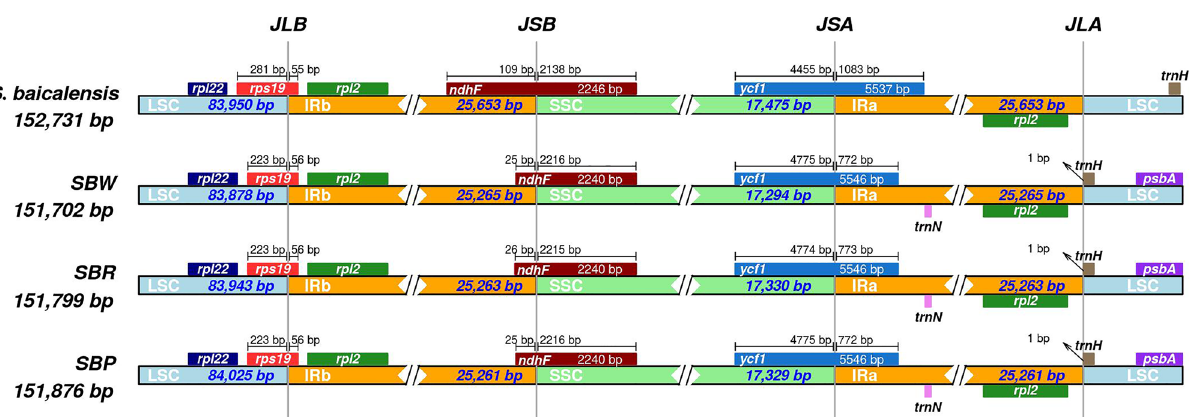
Figure 7. Comparison of quadripartite junction sites in three cultivated varieties cp genomes. Gene transcribed clockwise are presented below the track, whereas transcribed counterclockwise are presented on top of the track. The start and end of each gene from the junctions have been shown with arrows. The T scale bar above or below the track shows genes integrated from one region of the cp to another. JLB (IRb/LSC), JSA (SSC/IRa), JSB (IRb/ SSC), and JLA (IRa/LSC) denotes the junction sites between the quadripartite regions of the